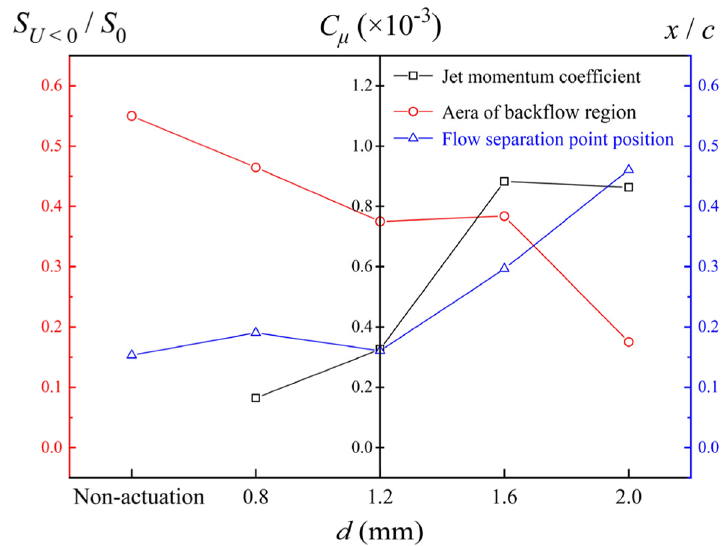
Fig. 14 Flow separation characteristic parameter and jet momentum coefficient variation according to the jet orifice diameter at α 12° =